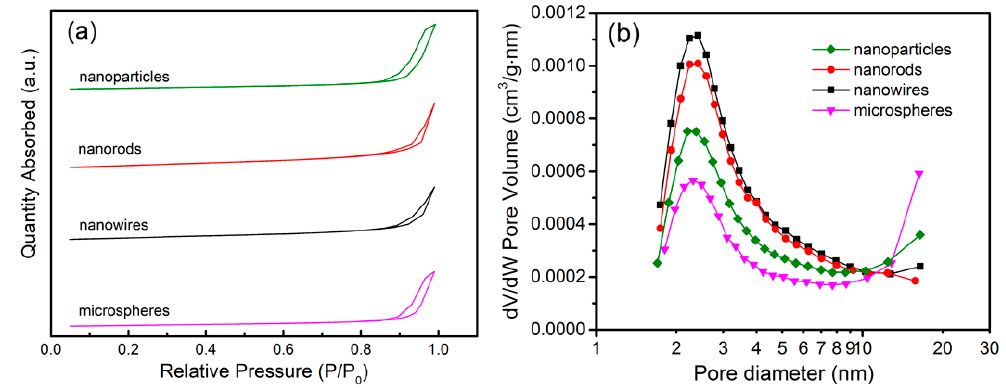
Appl. Sci. 2019 , 9 , x FOR PEER REVIEW 7 of 11 Figure 5. X-ray photoelectron spectroscopy (XPS) spectrum of as-prepared NiCo 2 O 4 nanowires: ( a ) survey spectrum; and binding energy spectrum of ( b ) Ni 2p; ( c ) Co 2p; ( d ) O 1s.